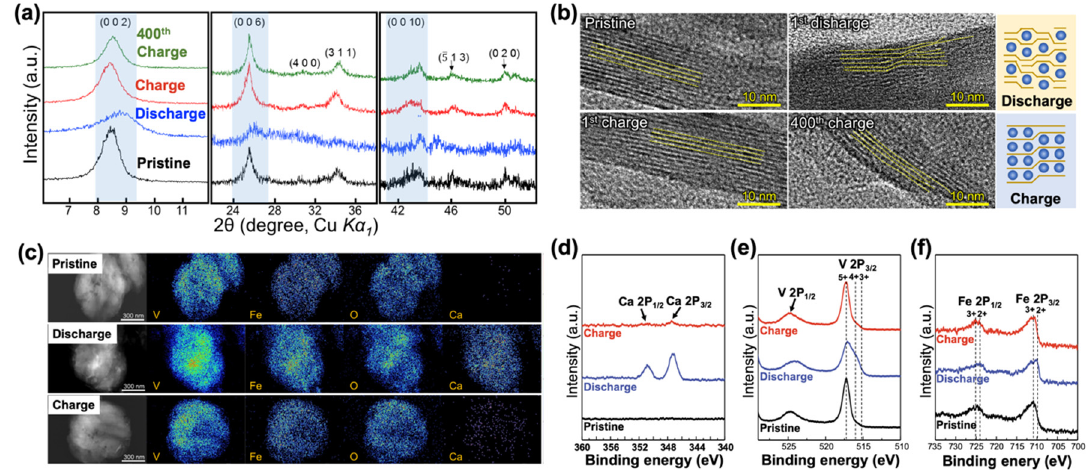
Figure 4. ( a ) XRD patterns, ( b ) high-resolution TEM images, ( c ) TEM-EDX images, ( d – f ) XPS survey spectra of Ca 2p, V 2p, and Fe 2p spin-orbitals for pristine FVO and FVO after first discharge cycle, first charge cycle, and 400th charge cycle.